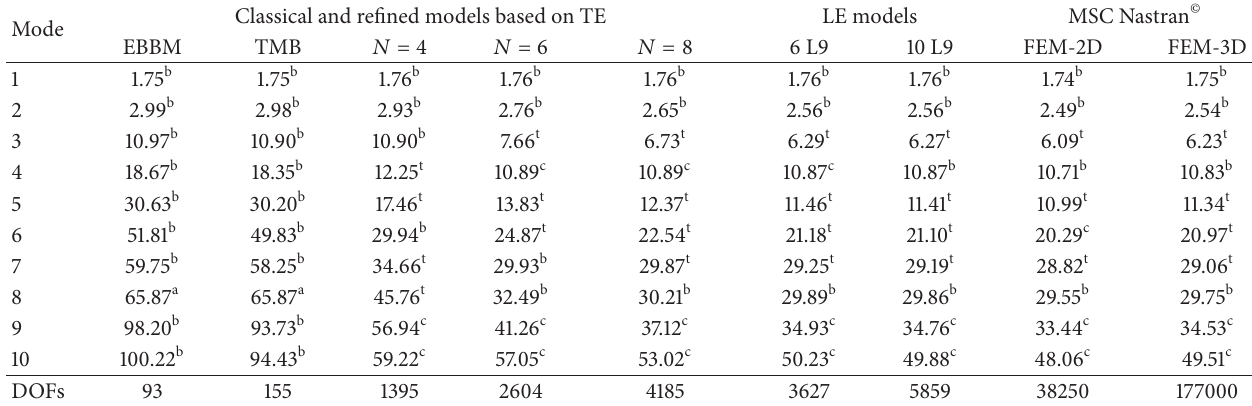
Figure 22: Modal shapes of the hollow-rectangular box beam with localized inertia at the tip cross-section (Figure 20(a), Case A). Table 1: First 10 natural frequencies (Hz) for the cantilever C-shaped